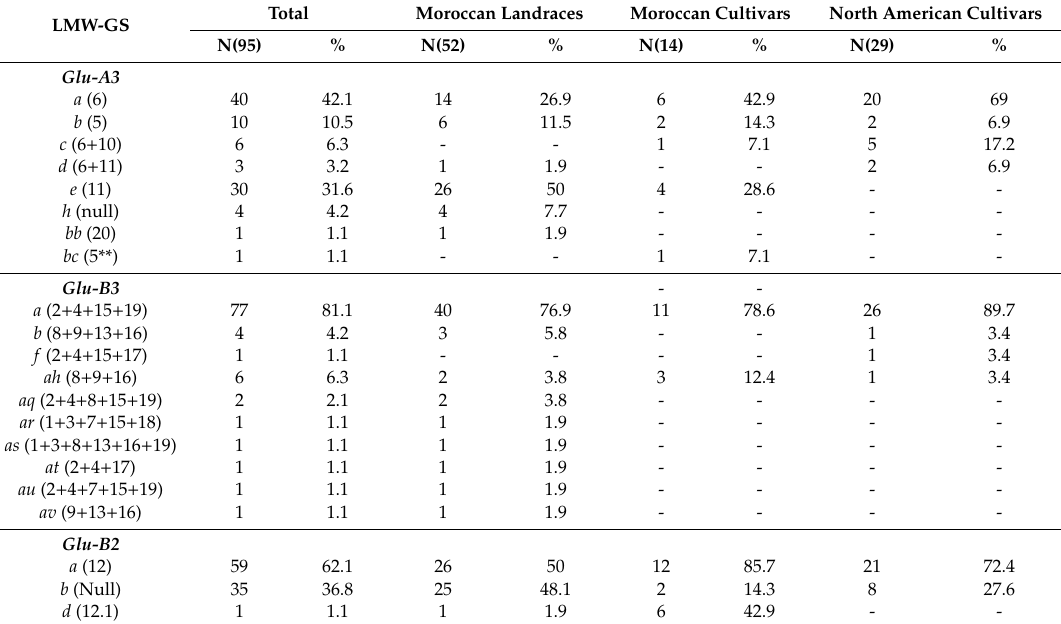
Table 2. Allelic frequency for each locus of LMW-GS in the materials